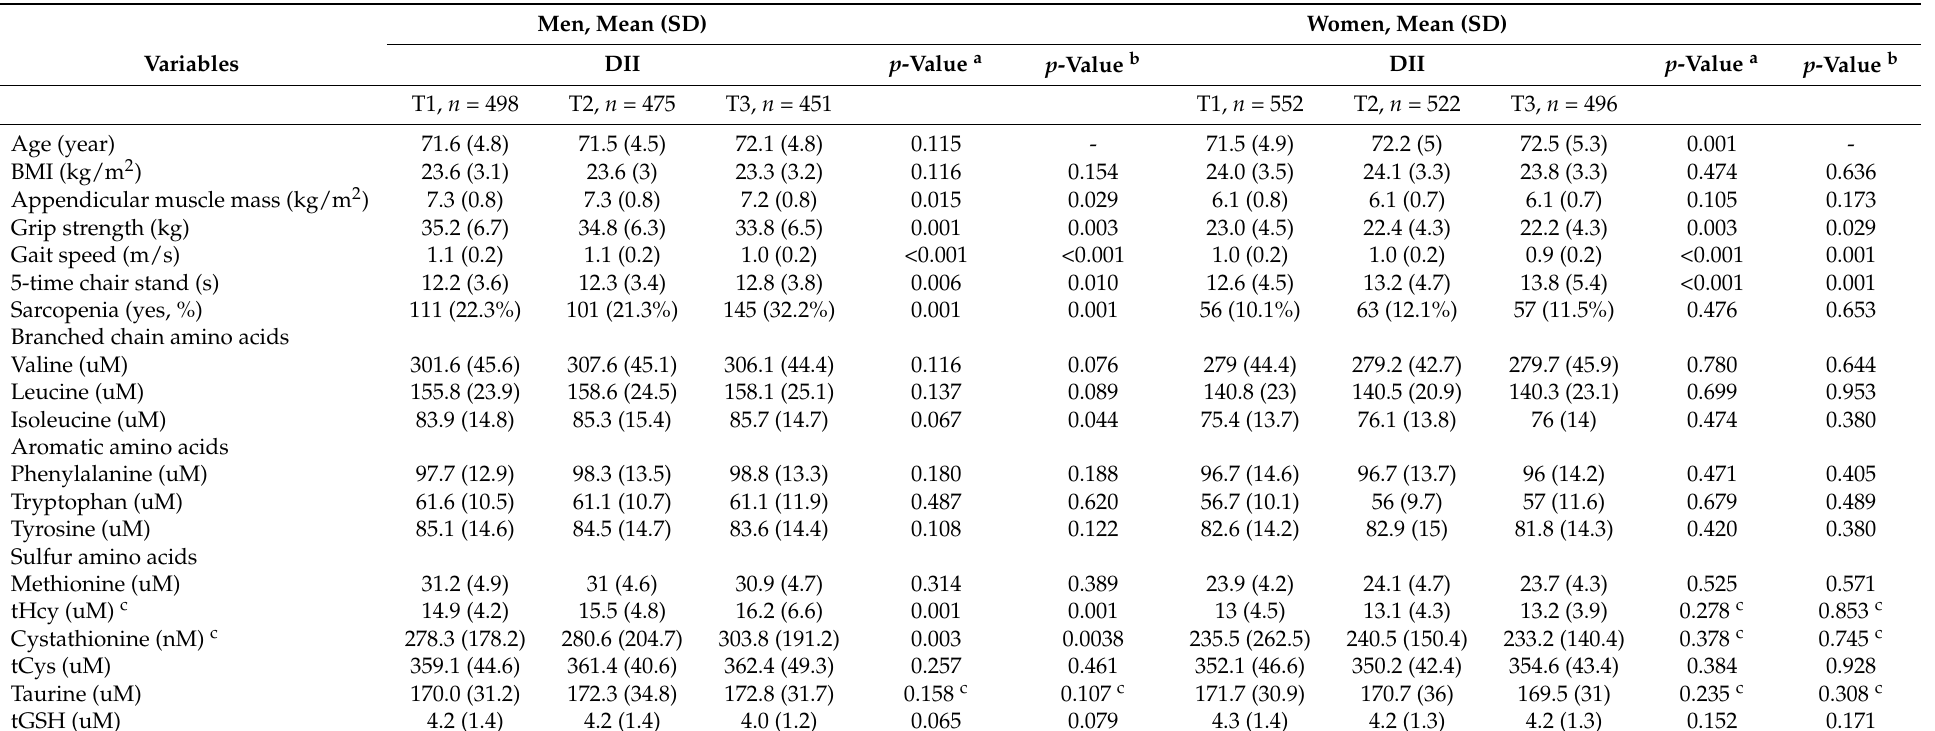
Table 1. The differences in muscular parameters and serum amino acids level of men and women among DII tertiles. Men, Mean (SD) Women, Mean